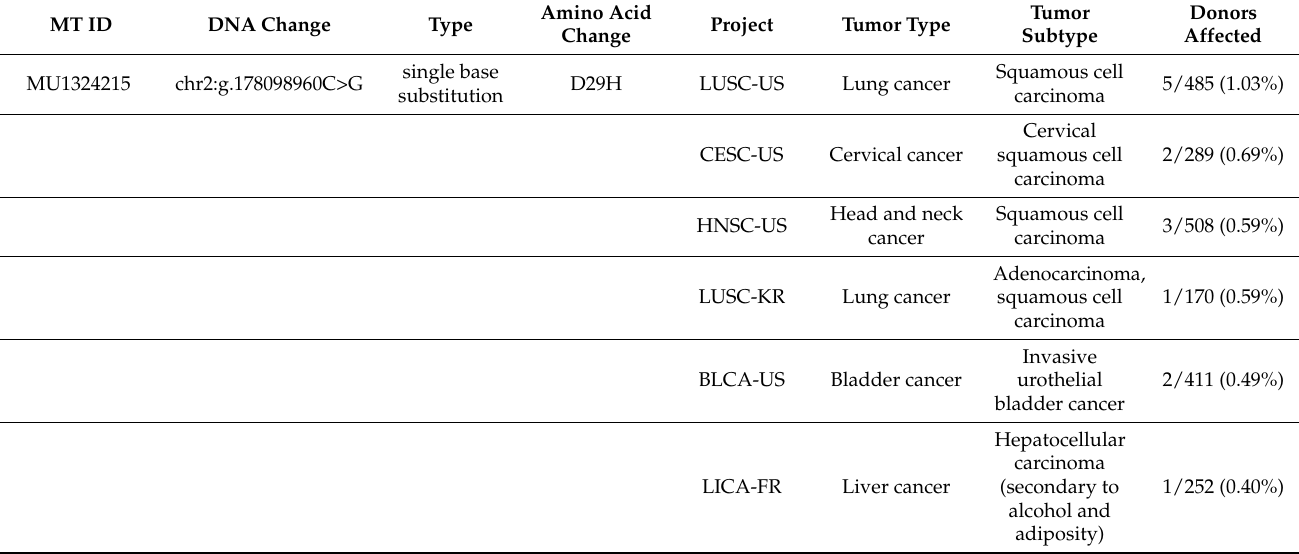
Table 1. Novel human NRF2 DLG MTs identified in different cancers and in ICGC